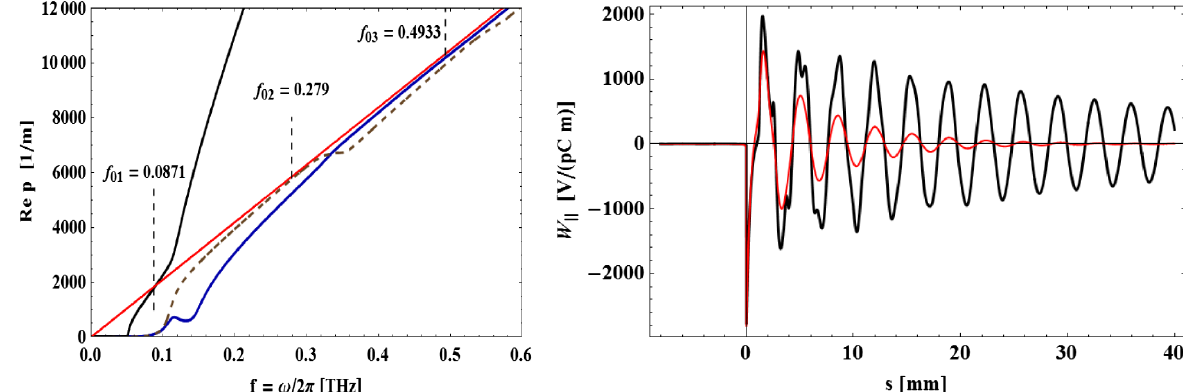
FIG. 9. Two-layer metal-dielectric waveguide for the case ε 00 1 ¼ 3 . Dispersion curves (left) for the TM 01 (black, solid line), TM 02 (black, dashed line), and TM 03 (blue, solid line) modes and longitudinal wake function (right) for ε 00 1 ¼ 3 (red line) and for ε 00 1 ¼ 0 . 5 (black line, for comparison).